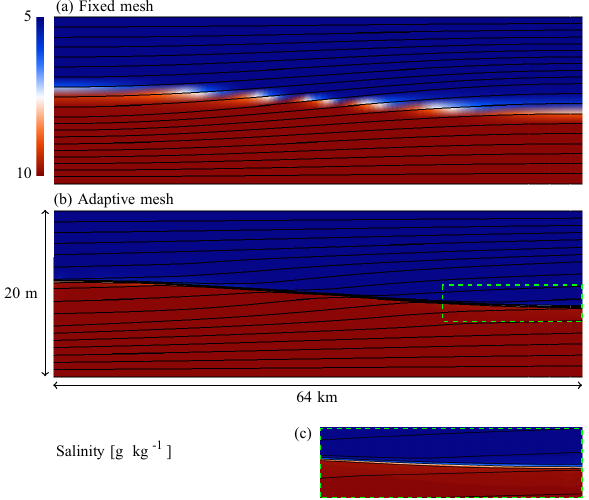
Figure 9. Comparison between the internal seiche modelling with (a) fixed and (b) adaptive meshes. The black lines show the differ- ent mesh levels. While the first one induces important numerical mixing at the interface, the interface remains sharp in the second one. (c) Zoom of the area delimited by the green rectangle in (b) , showing two levels with the highest vertical permitted resolution on both sides of the